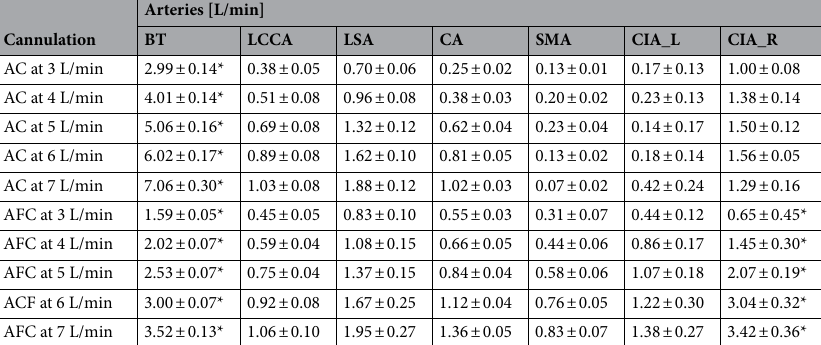
Table 2. Flow data of entire arteries in AC and AFC for the 4D flow MRI experiment 22 . AC axillary cannulation, AFC axillary and femoral cannulation, BT brachiocephalic trunk, CA celiac artery, CIA_L left common iliac artery, CIA_R right common iliac artery, 4D flow MRI four-dimensional flow magnetic resonance imaging, LCCA left common carotid artery, LSA left subclavian artery, SMA superior mesenteric artery. *Indicates that the inflow and flow data are expressed as the mean ± standard deviation.